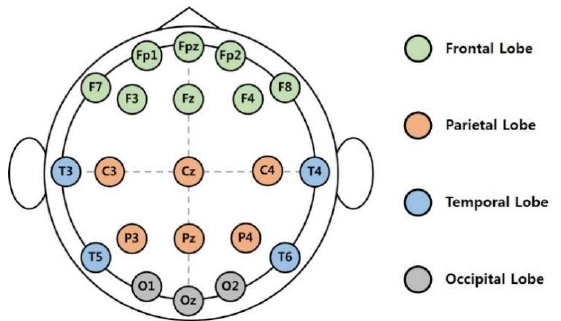
Figure 1. The 10–20 international system of electrode placement.